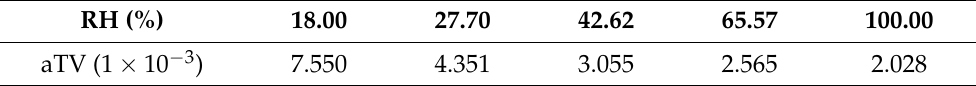
Table 4. Noise metric applied to measured voltage points in each polarization curve.